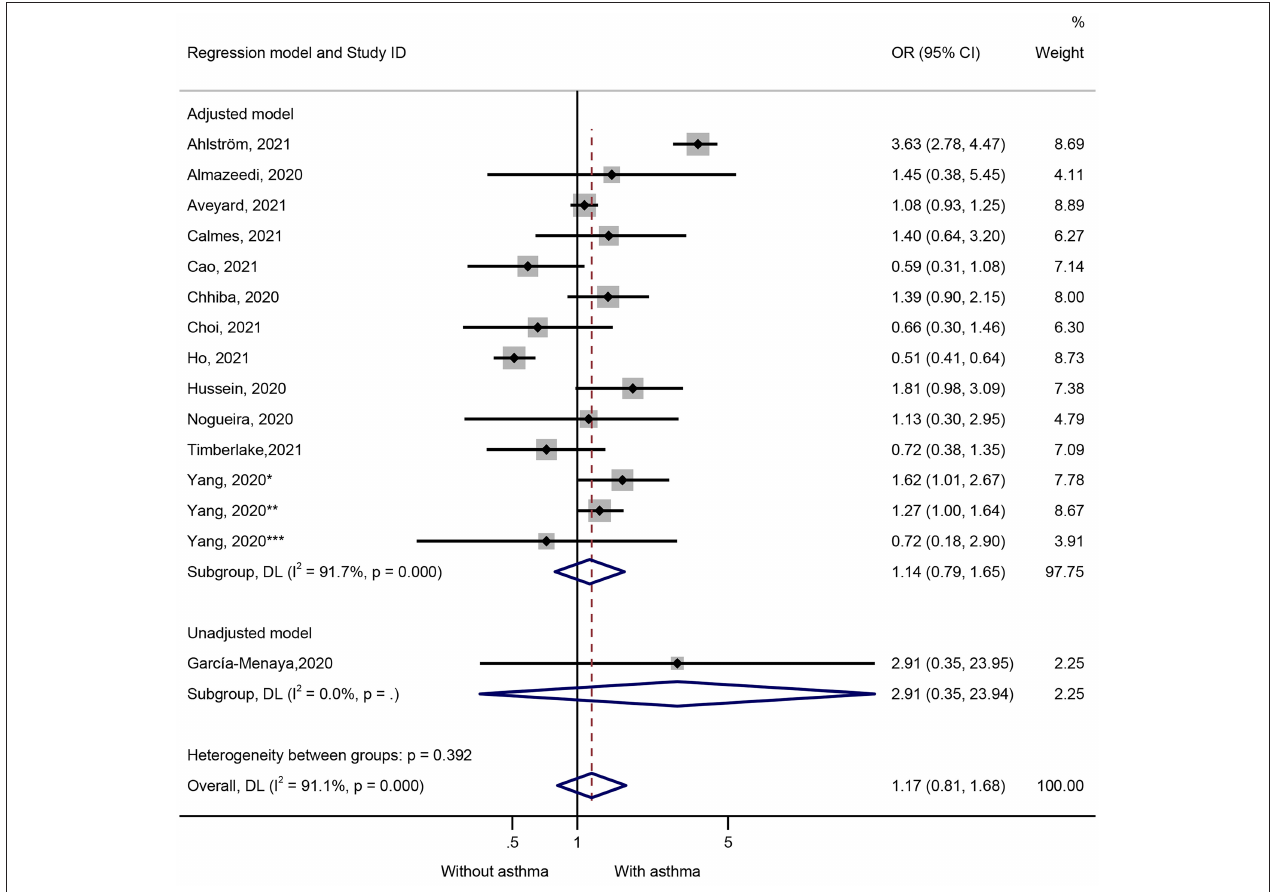
FIGURE 3 | Forest plot of ICU admission comparing patients with or without preexisting asthma by the model applied. Weights and between-subgroup heterogeneity test are from random-effects model.